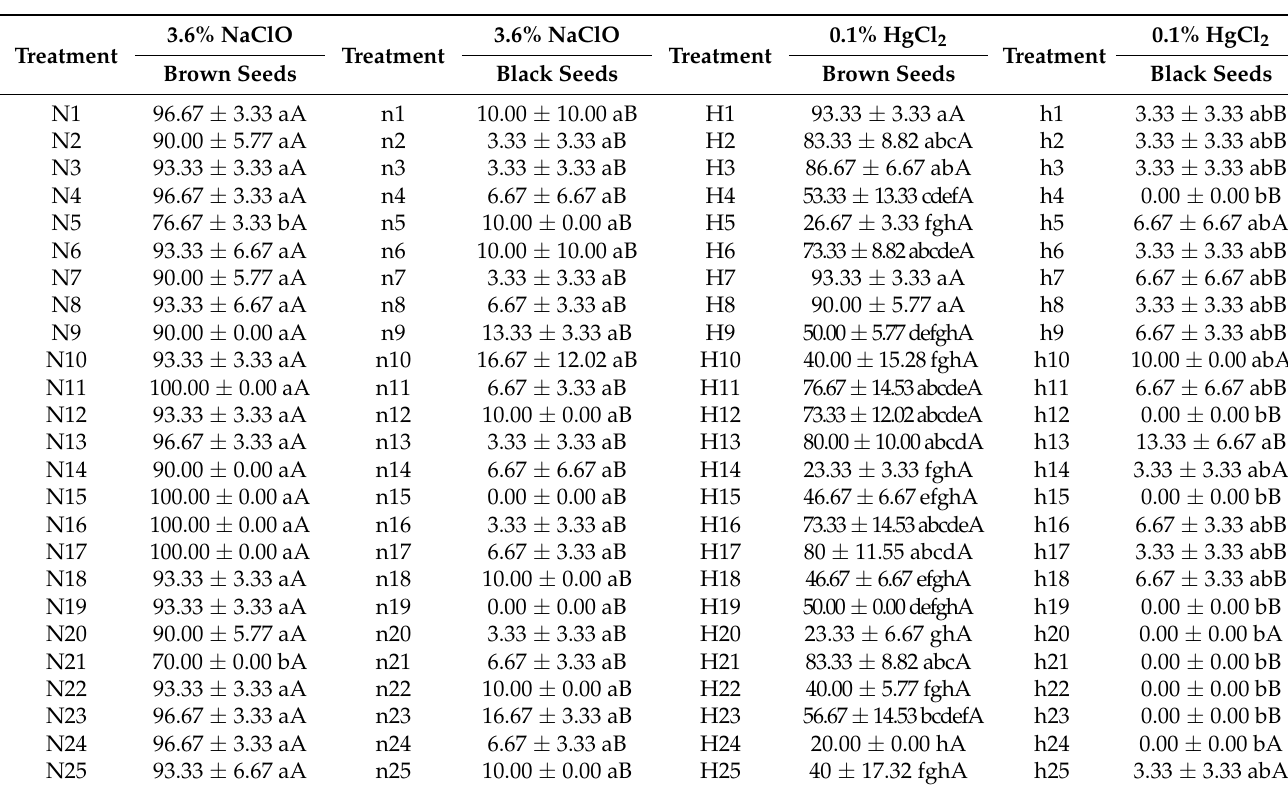
Table 3. Final germination percentages of Suaeda aralocaspica seeds cultured with different treatments after 20 days incubation.